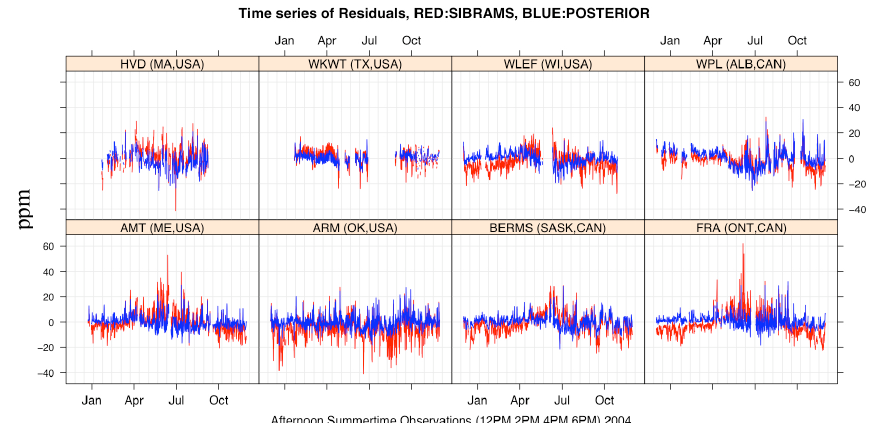
Figure 3: Time series plots of carbon dioxide residuals based upon SiBRAMS prior (red) and inversion posterior (blue) (observations – model).